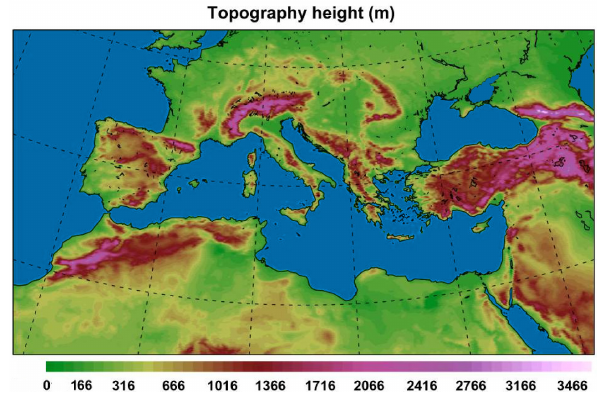
Fig. 2. The integration domain and the resolved topography (m) for the entire experiments referred in this